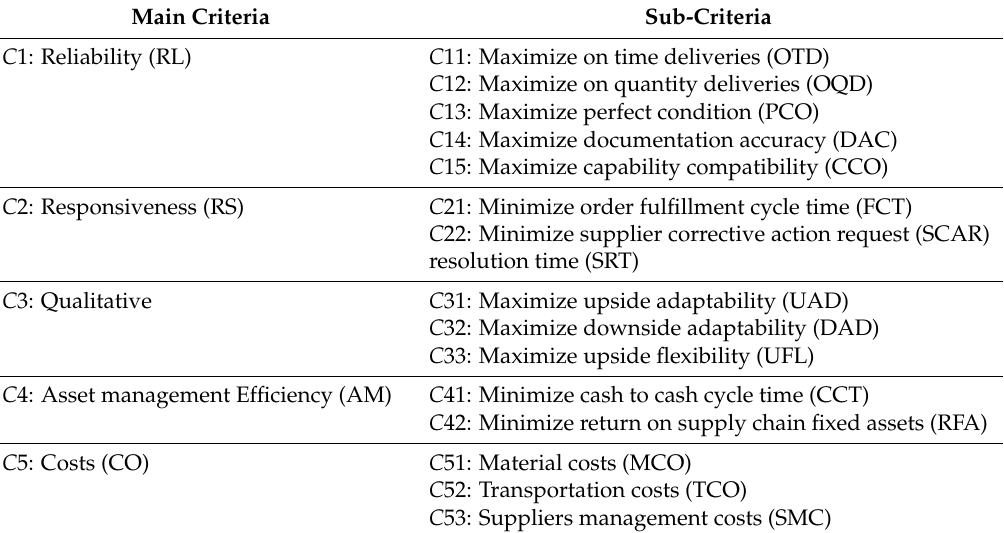
Table 4. List of main criteria and